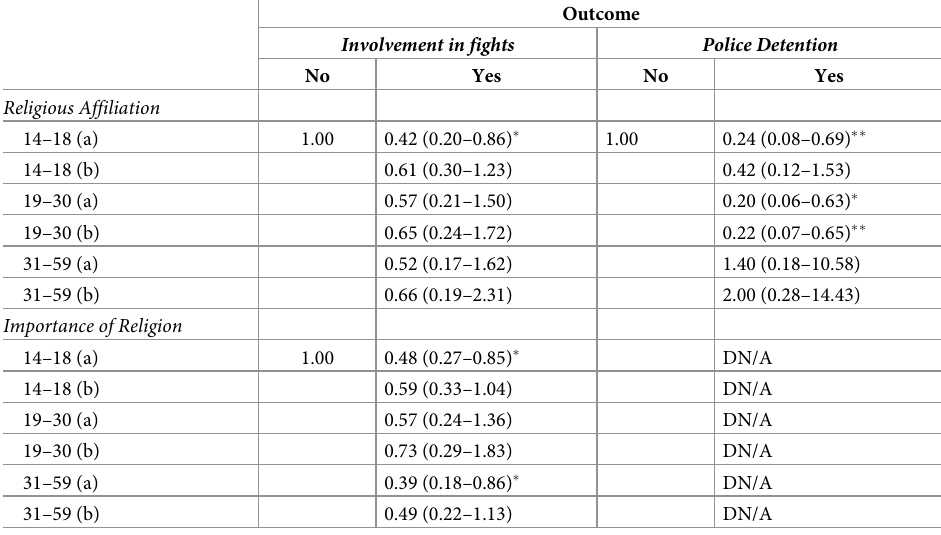
Table 4. Associations between violence outcomes and religiosity stratified by age group, Brazil,